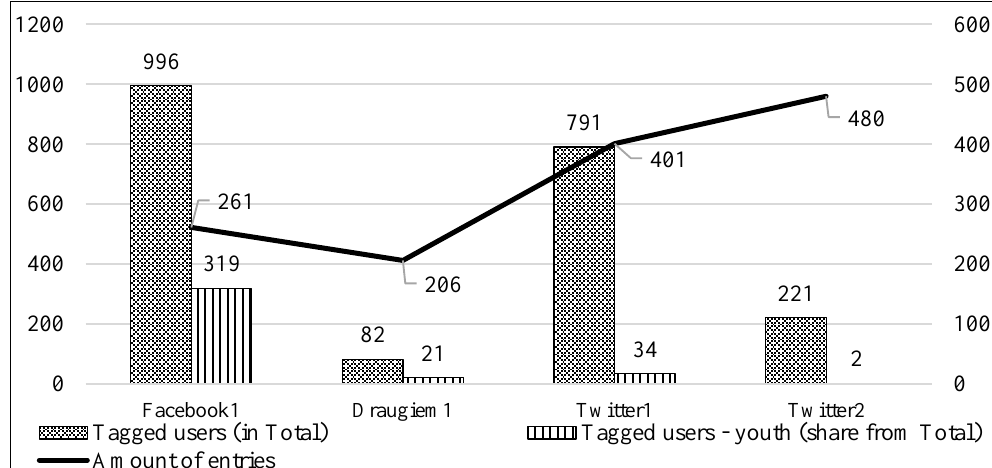
Fig. 2. European Parliament’s social media entries from 1 July to 31 December 2015. Total amount of tagged users by each social media account and tagged users that are connected with youth (share from